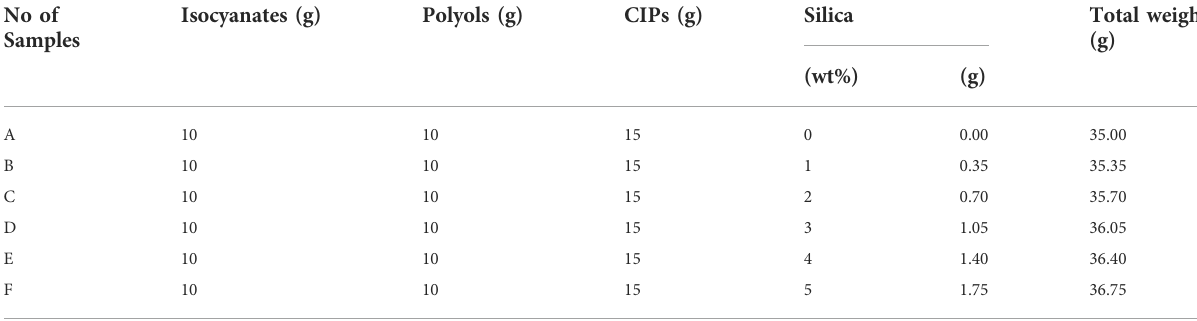
TABLE 1 Materials composition in fl exible MR foam with addition of silica